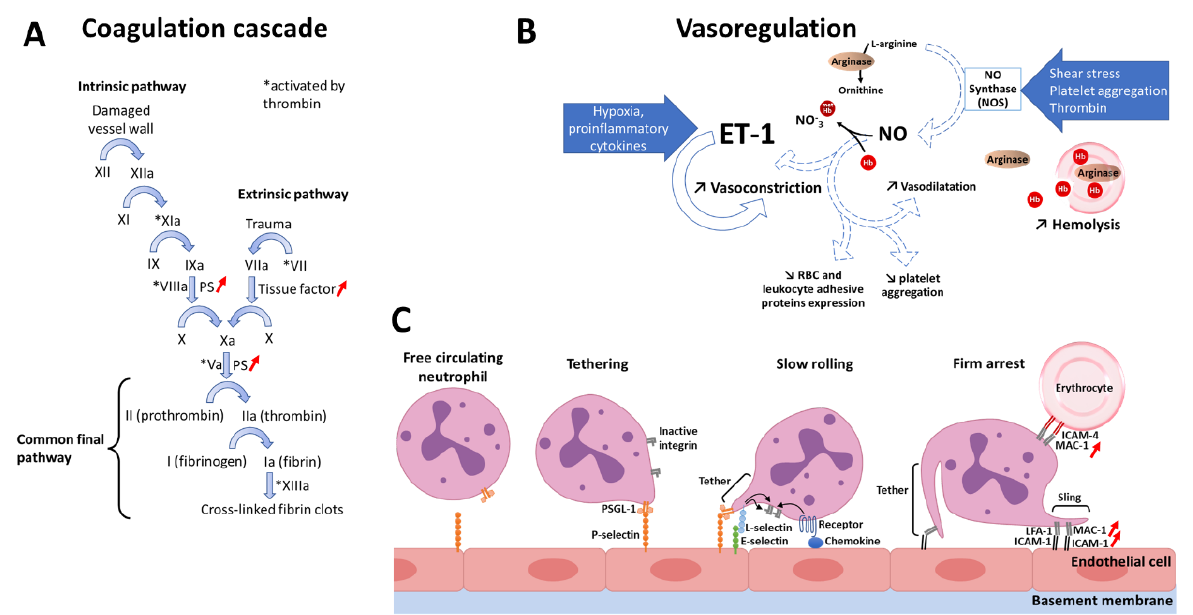
Figure 3. Pro-coagulant and pro-inflammatory context in SCD. ( A ) In SCD, phosphatidylserine (PS) and tissue factor (TF) are exposed at elevated levels by several cell types and microparticles, which contributes to the increased activation state of this coagulation cascade; ( B ) The high hemolysis rate observed in SCD, contributes to the loss of vasodilatory reserve reported in this disease. Indeed, following hemolysis, free arginase will deplete the substrate allowing to form nitric oxide (NO), and free hemoglobin will carry out NO-scavenging. Therefore, the level of the vasoconstrictor endothelin-1 (ET-1) is increased; ( C ) Several mechanisms including increased interactions of erythrocytes with endothelial cells, allow the overexpression of intercellular adhesion molecule-1 (ICAM-1). Moreover, SCD neutrophils have been shown to overexpress the integrin macrophage MAC-1, thereby allowing increased interaction with the vascular endothelium and with